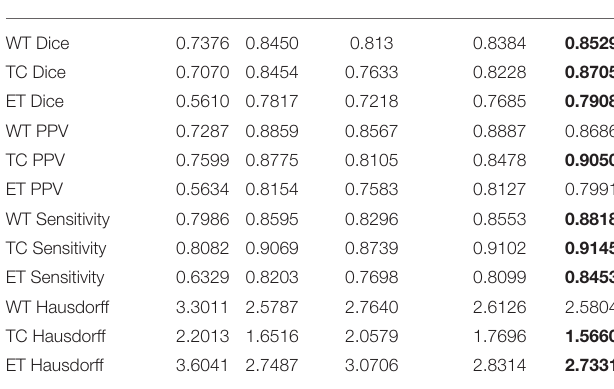
In Equation (17), the σ denotes the standard variance of the image, and N denotes the total number of pixels of the matrix X represented by the image.